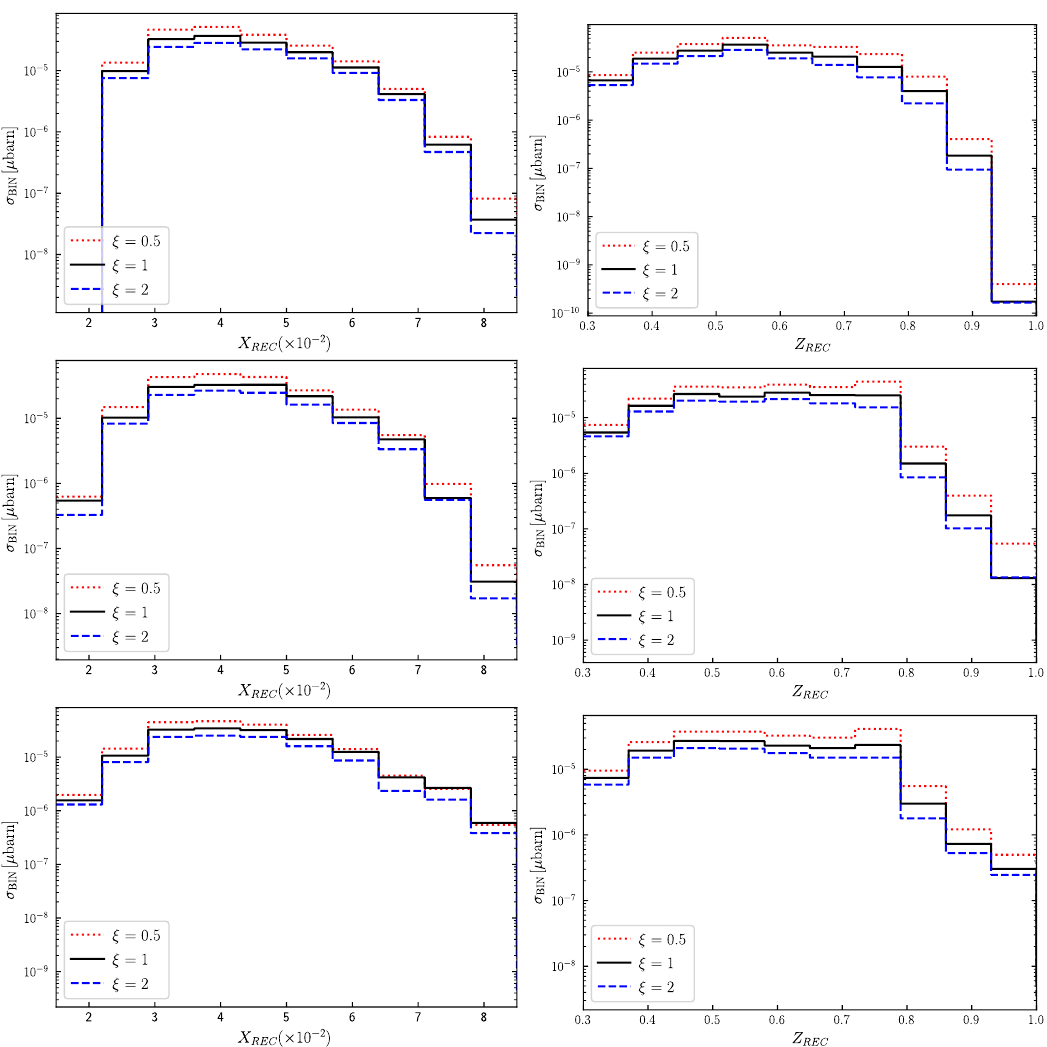
( ξ = 1 / 2,1,2 ) , showing the distributions Figure 17: Histograms based on the datasets D in X (left column) and Z (right column). Each datapoint is weighted using REC REC the integrated cross-section per bin. We explored the three reconstruction methods mentioned in Sec. 4: linear method (first row), Gaussian regression (second row) and neural networks (third